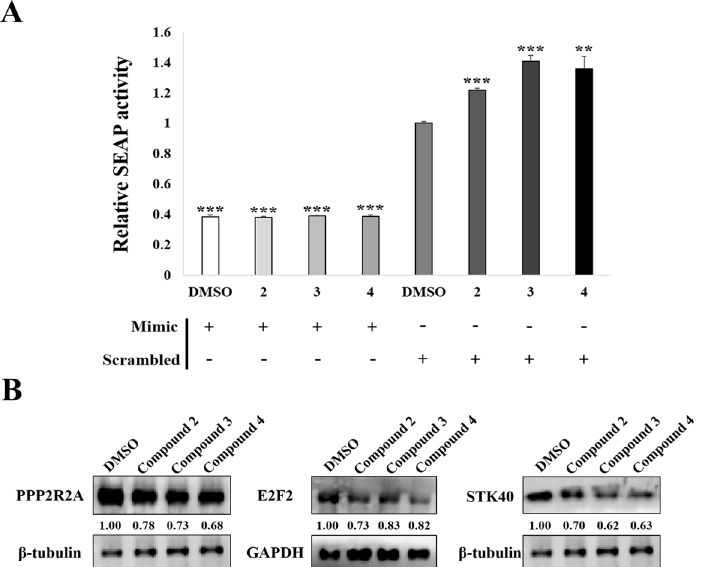
Fig 7. Abolition of aminosulfonylarylisoxazole derivative function by miR-31 mimics. HEK-293T cells were transfected with mature miR-31 mimics and SEAP reporter constructs containingmiR-31 bindingregion in the 3’UTR of the reporter gene in the presenceof compounds2, 3, or 4, after which SEAP activity was measured(A). A549 cells were treated with miR-31 mimics and compounds2, 3, or 4, and protein expression levels of PPP2R2A, E2F2, and STK40 was measured(B). ScrambledmiRNA mimics were used as negative control. Data represent values from three independentexperiments with similar results. Statistical significance was shown comparedto DMSO control treated with scrambledmiRNA